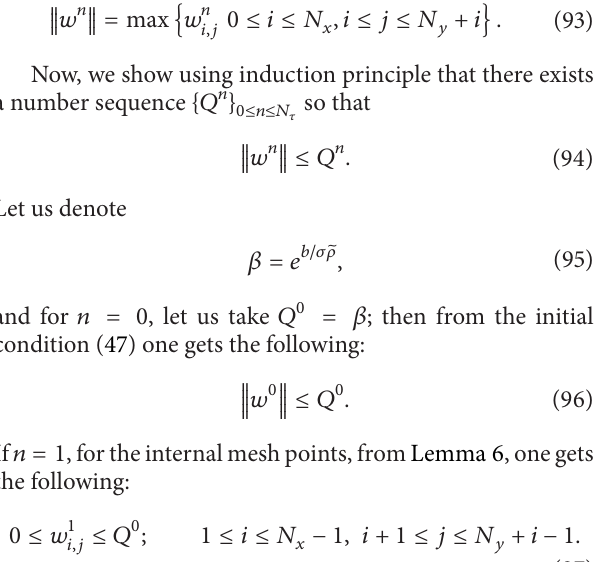
Figure 3: Error of numerical